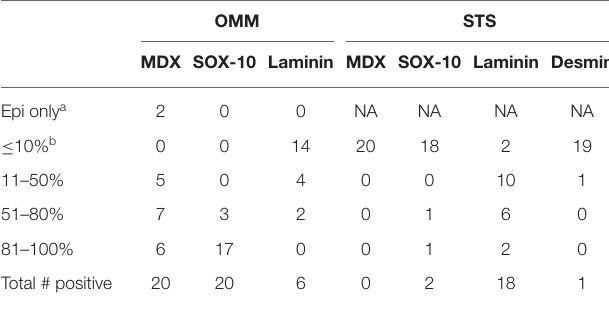
TABLE 1 | Number of cases with immunohistochemical expression of tested antibodies in oral malignant melanomas (OMM) and soft tissue sarcomas (STS). OMM STS